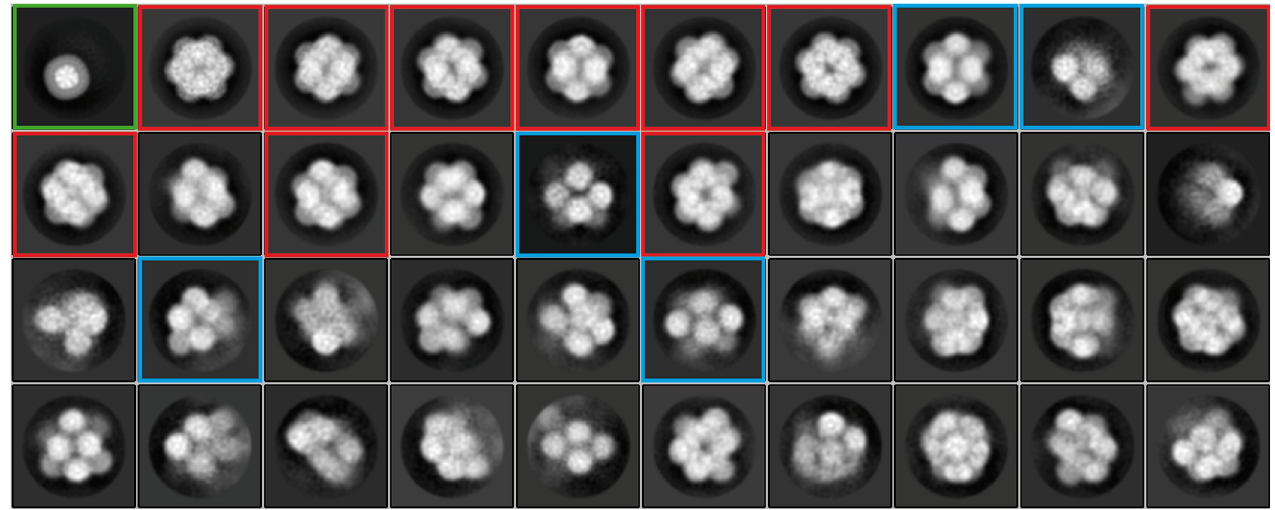
Fig 1. Two-dimensional class averages computed from the initial set of particles. 2D class averages are sorted in row-major order according to the number of images contained within each class (top left class: highest number of particles; bottom right class: lowest number of particles). The 2D class average within the green frame represents an isolated pentameric capsomere and encompasses 4,869 particles. The 2D class averages within red frames correspond to compact, full-capsid assemblies that were used for further processing (38,728 particles). The 2D class averages within blue frames are examples of loose viral particles or partial assemblies of pentameric